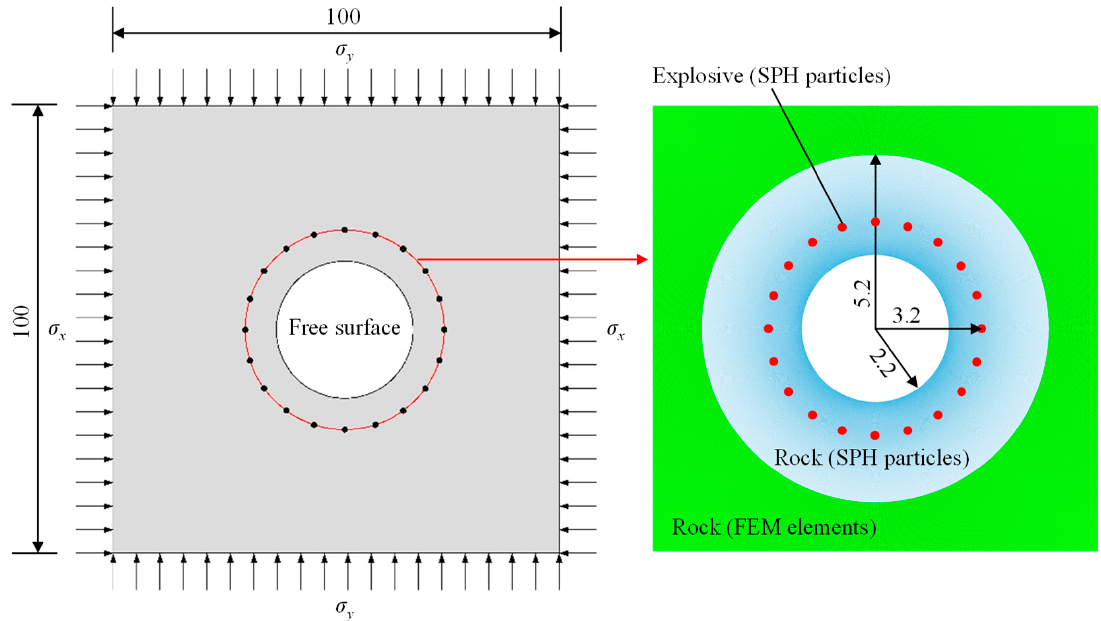
Figure 5. Numerical model of the multiple-hole blasting in the circular tunnel excavation (unit: m).